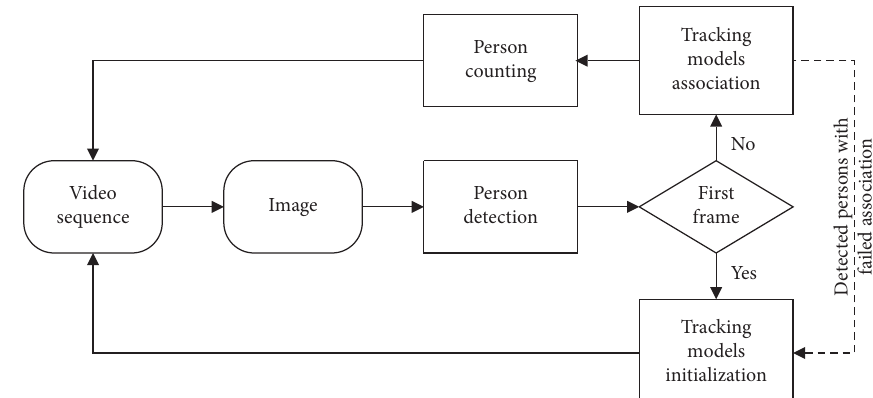
Figure 2: Overall diagram of a person counting system. The system processes images streamed by a monocular camera. Each image is firstly examined for a presence of persons. Positive samples are then associated with existing tracking models of persons. If sample is not associated with any existing model, a new model is initialized. If a tracking model leaves scene, which is defined by virtual lines, counting is